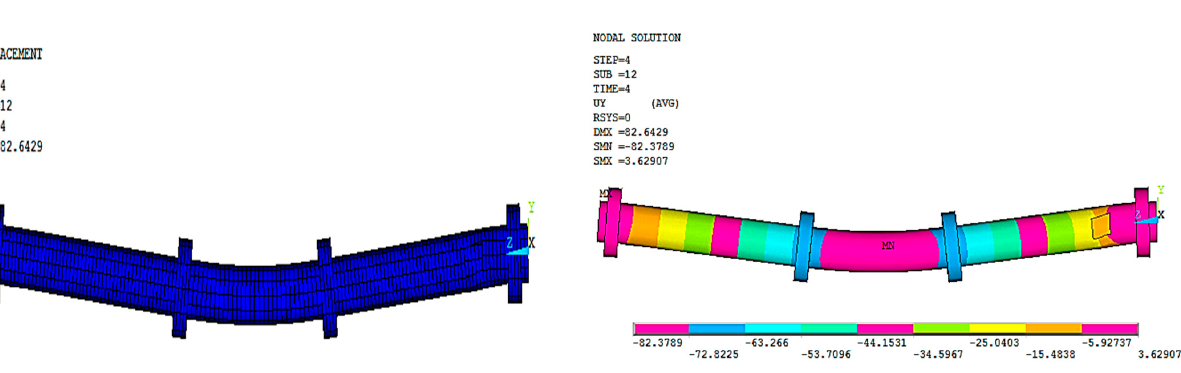
Figure 15. Results of the second group specimens in parametric case studies.